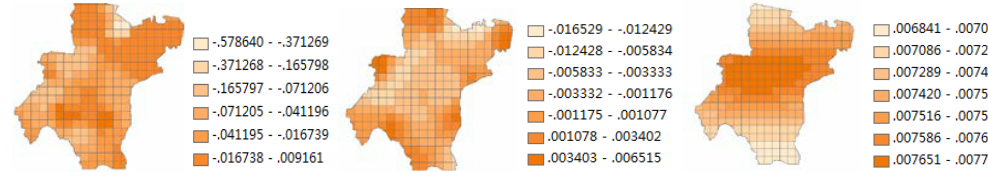
Fig.5 Geographic weighted regression analysis results of shrub category